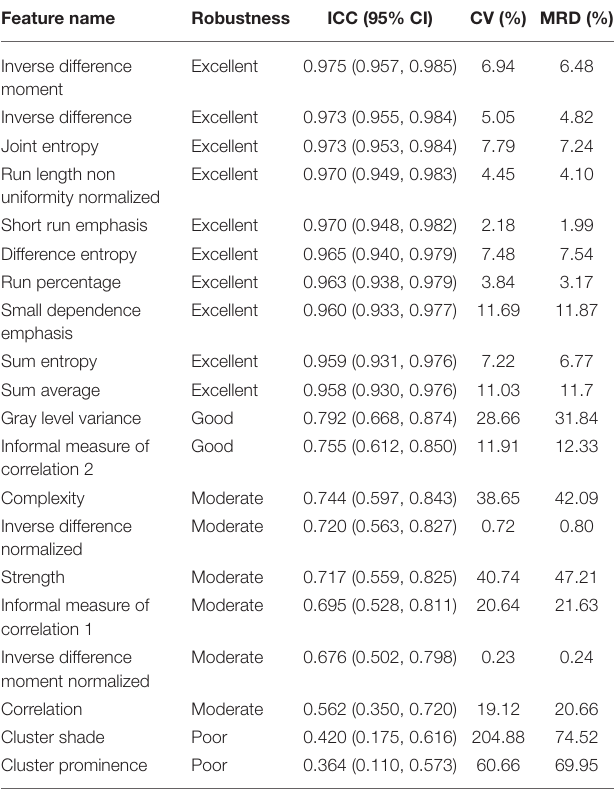
TABLE 6 | The 10 most and 10 least robust left ventricular myocardium texture features in